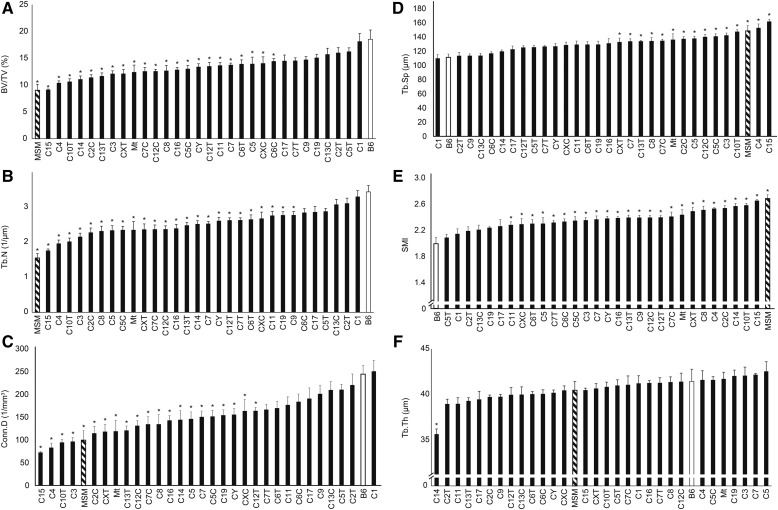
Screening of trabecular bone features among B6, MSM, and the consomic strains. B6, MSM and the consomic strains are aligned in ascending order of each measurement value for the micro-CT results. All measurement values of the parameters BV/TV (A), Tb.N (B), Conn.D (C), Tb.Sp (D), SMI (E), and Tb.Th (F) were obtained from 10-wk-old males. The consomic strain B6-ChrNMSM is abbreviated as CN, where N is the number of the chromosome transferred from MSM. CNC and CNT (e.g., C13C and C13T) denote consomic strains that harbor the centromeric and telomeric half of MSM-derived chromosomes. Y and Mt denote consomic strains that harbor the Y chromosome and mitochondrial genome of MSM, respectively. The measurement values of each consomic strain were compared with those of B6. Dunnett’s test was performed for statistical analysis. Significance is declared when *P < 0.05 (vs. control B6).